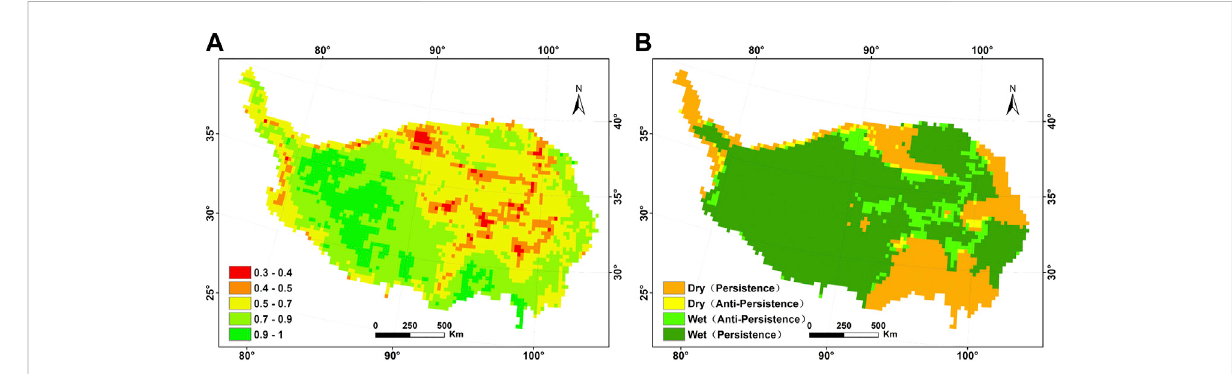
FIGURE 3 Spatial distribution of Hurst index (A) and persistence analysis (B)